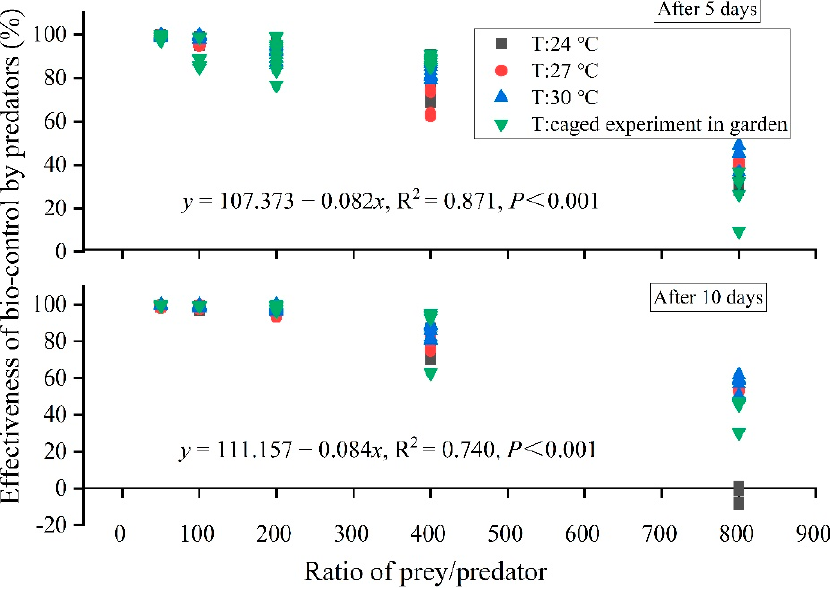
Figure 5. Effectiveness of biocontrol (EBC) by ladybird beetle predators against cotton aphids in relation to the prey/predator ratio in laboratory experiment and caged experiment in the garden (CEG).